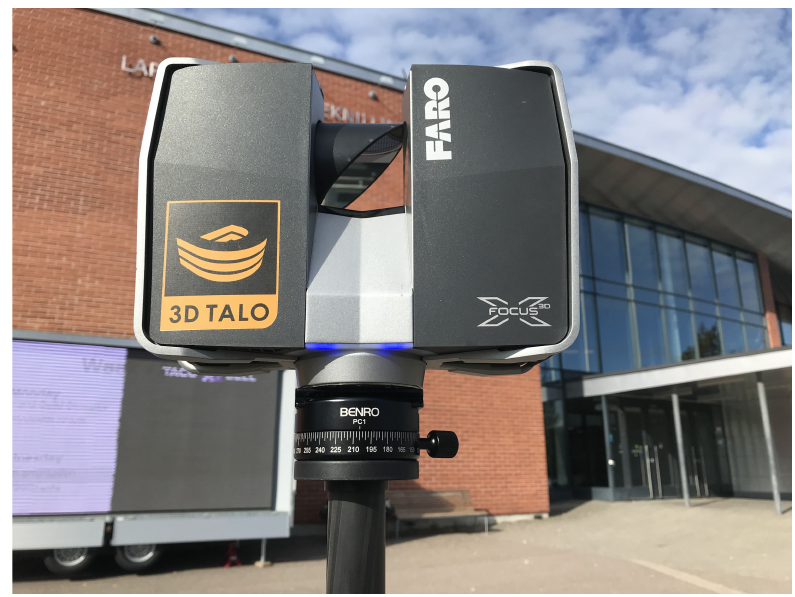
Figure 7. FARO S70 laser scanner.